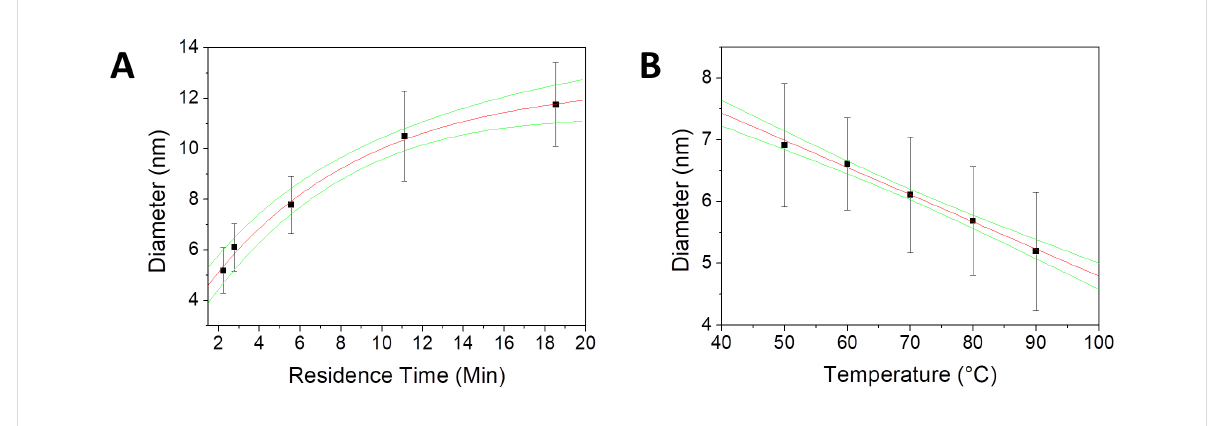
Figure 5: Analysis of particle sizes in droplet synthesis. Nanoparticle diameter as a function of the residence time of droplets in the reactor (A), and nanoparticle diameter as a function of the reaction temperature (B). In both graphs, the measured particle diameters are indicated by black squares, the standard deviation of the measured particle diameters is shown by black error bars. An exponential function was fitted in the case of (A) and a linear function was fitted for (B) (red lines). Green lines indicate the 95% confidence interval on the fitted functions. The R-square value for the expo- nential fit (A) is 0.986 and, respectively, 0.992 for the linear fit